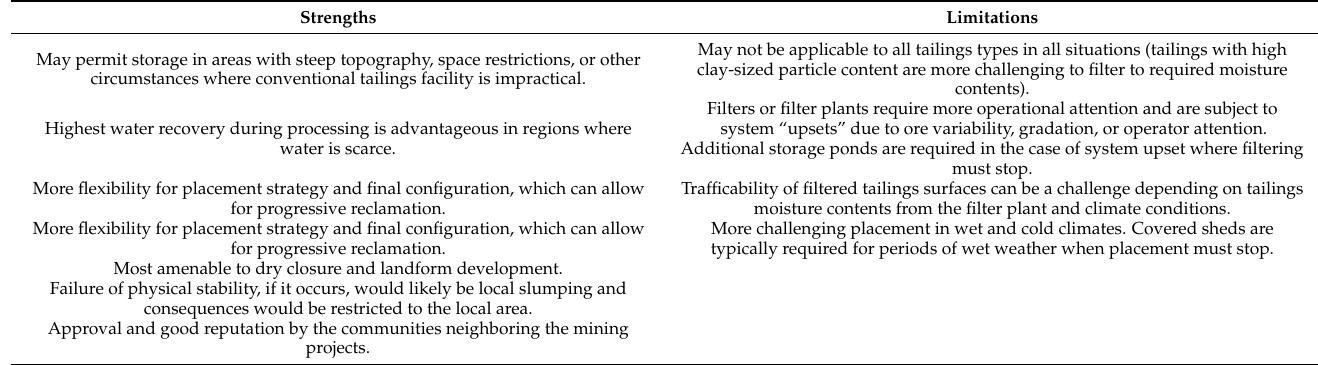
Table 5. Strengths and Limitations considering Practical Experience of Filtered Tailings in Chile and